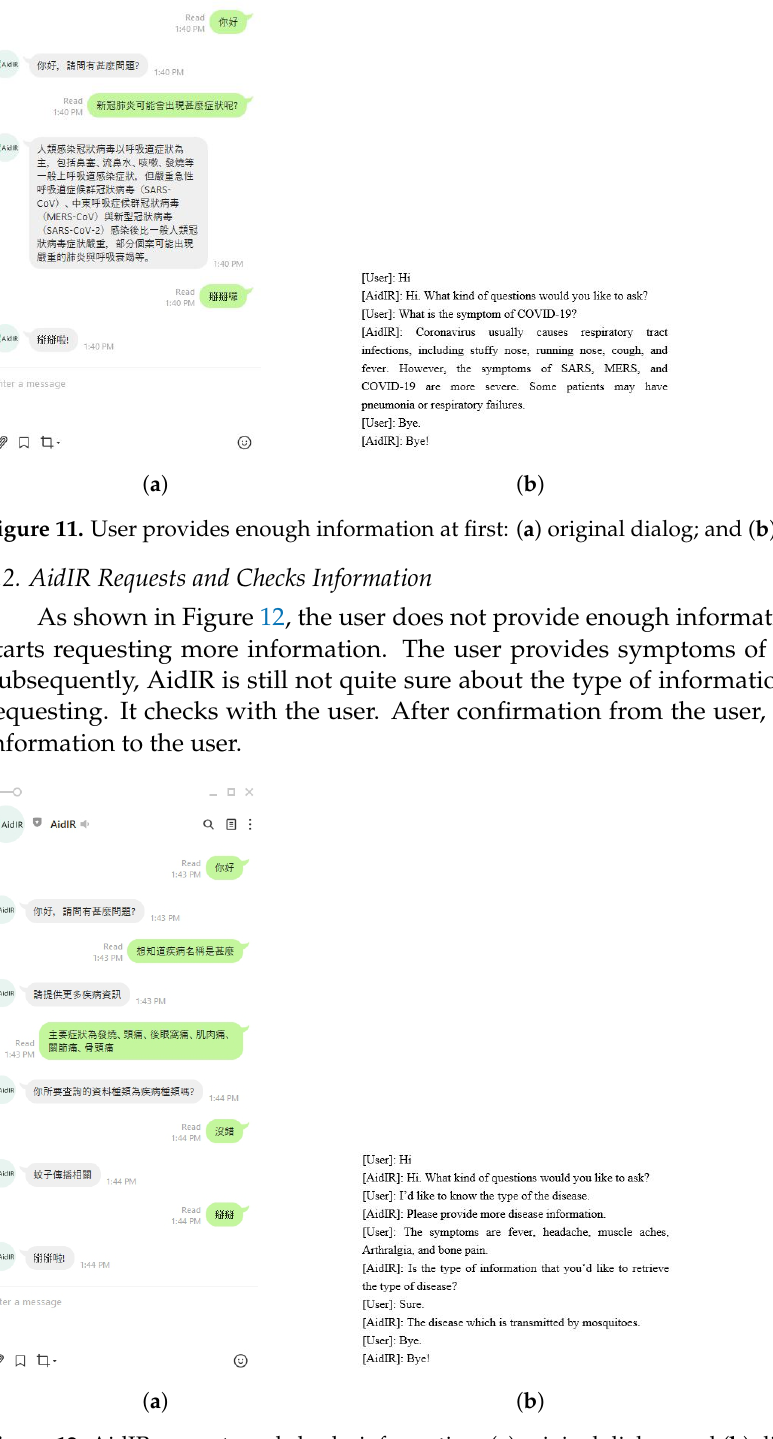
Figure 12. AidIR requests and checks information: ( a ) original dialog; and ( b ) dialog in